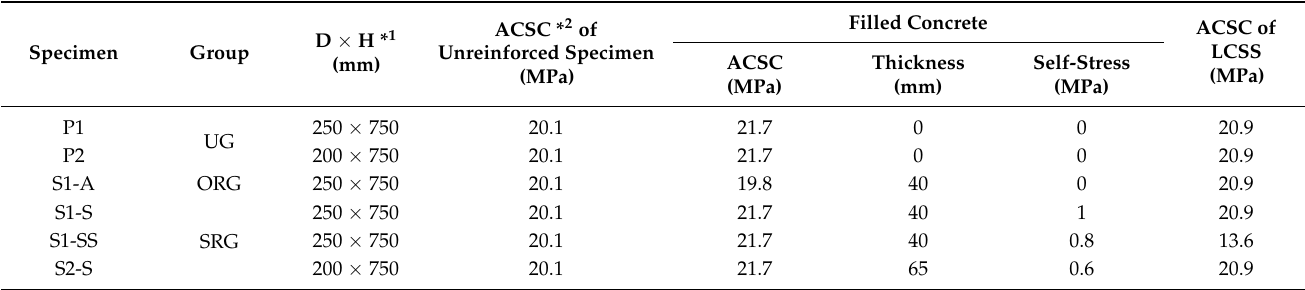
Table 3. Parameters and grouping of specimens.